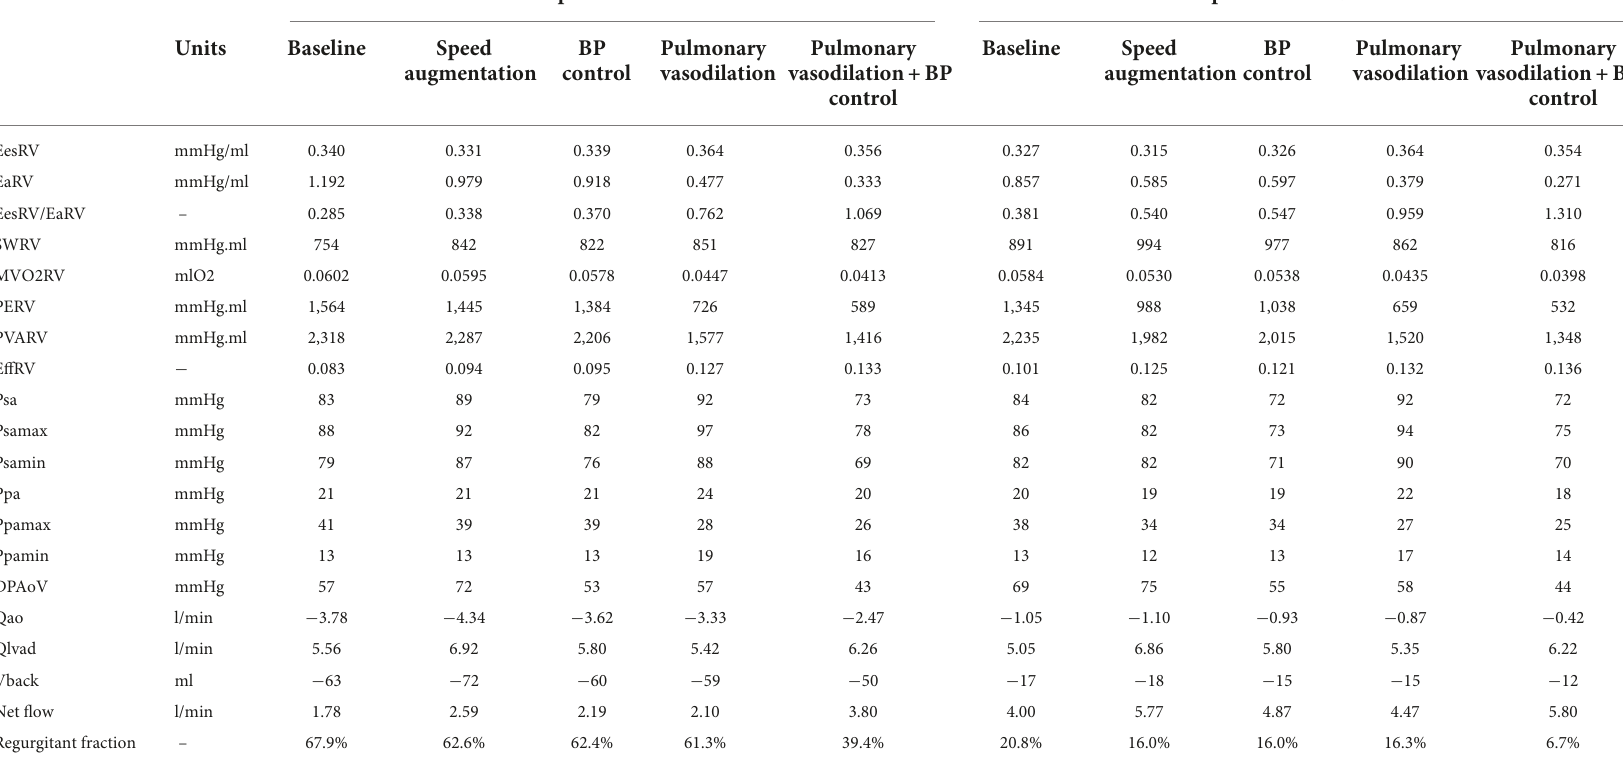
TABLE 2 Intracardiac hemodynamics, energetics, left ventricular assist device (LVAD), and aortic flow with an uncoupled right ventricle with varying degrees of aortic